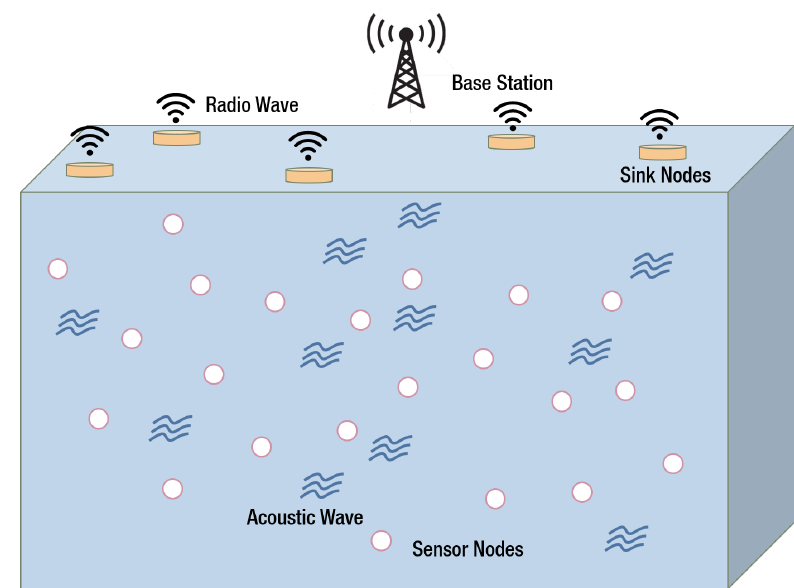
Figure 7. Network architecture in Reliable Energy Efficient Pressure Based Routing (RE-PBR)